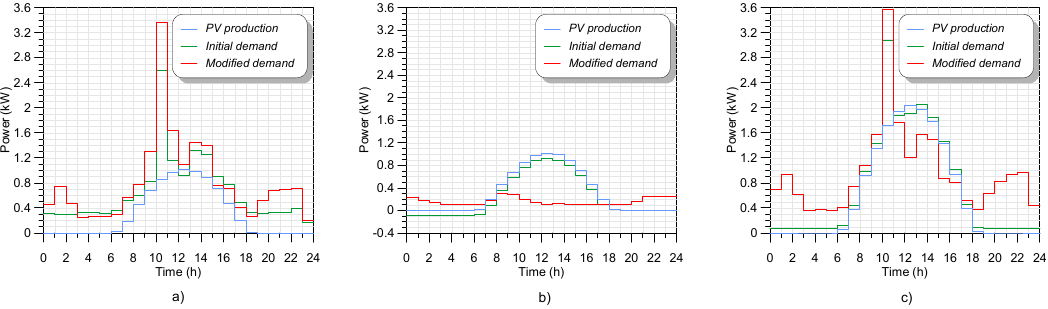
Figure 6. Profiles of generation, initial demand, and modified demand for: ( a ) prosumer 1 individual scheduling; ( b ) prosumer 2 individual scheduling; and ( c ) global (prosumer 1 + prosumer 2) coordinated scheduling.